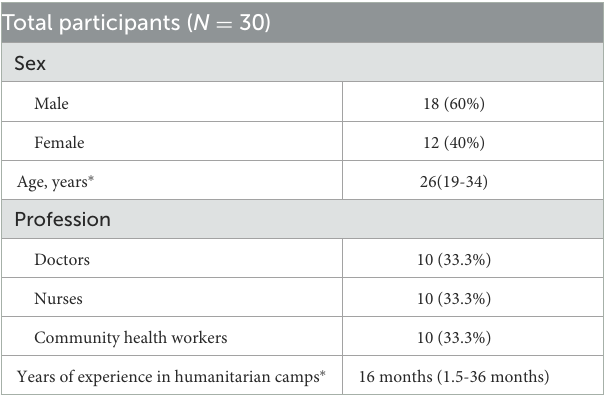
TABLE 1 Characteristics of the sample of 30 frontline healthcare